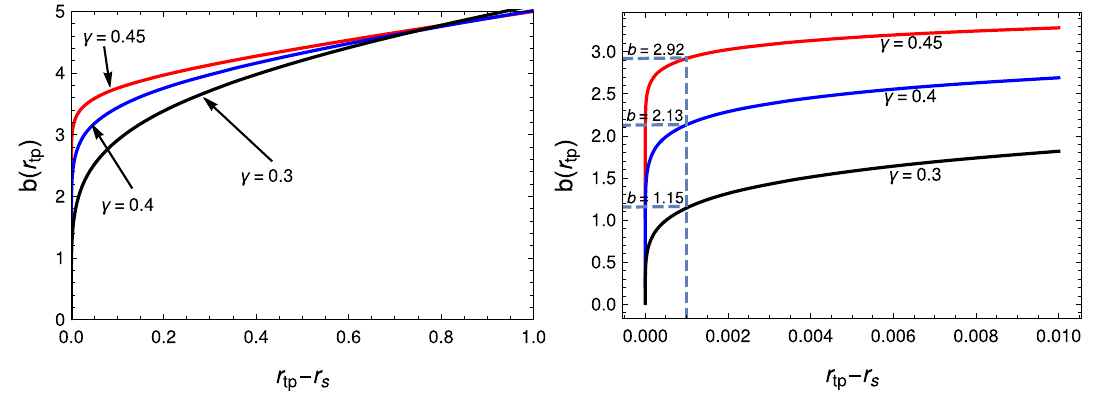
Fig. 4 Impact parameter as a function of the turning point r tp on the equatorial plane. The vertical dashed line corresponds to turning point r tp = r s + 0 . 001. The corresponding impact parameters for this turning point are 2 . 92 2 . 13 and 1 . 15 for γ = 0 . 45, 0 . 4 and 0 . 3, respectively. Here, we have considered M = 1 ence | (cid:12) r | (cid:12) |˙ r | (cid:12)λ in r between two successive